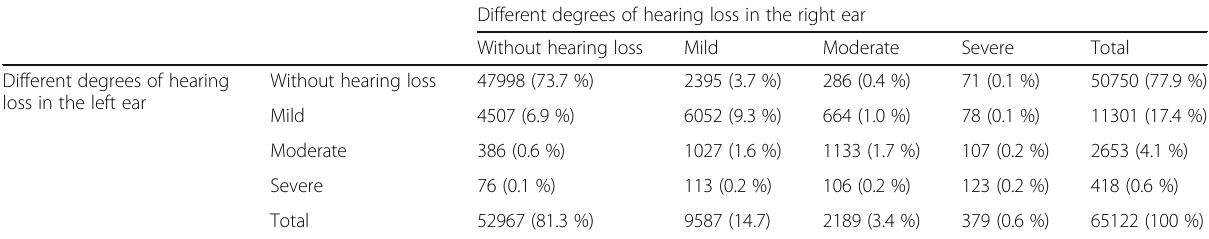
Different degrees of hearing loss in the right ear Without hearing loss